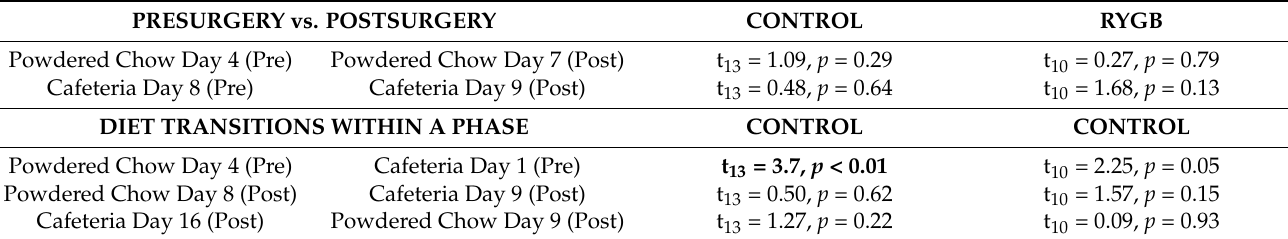
Table 13. Paired t -tests Comparing 22-H Intermeal Interval within Groups across Diets.